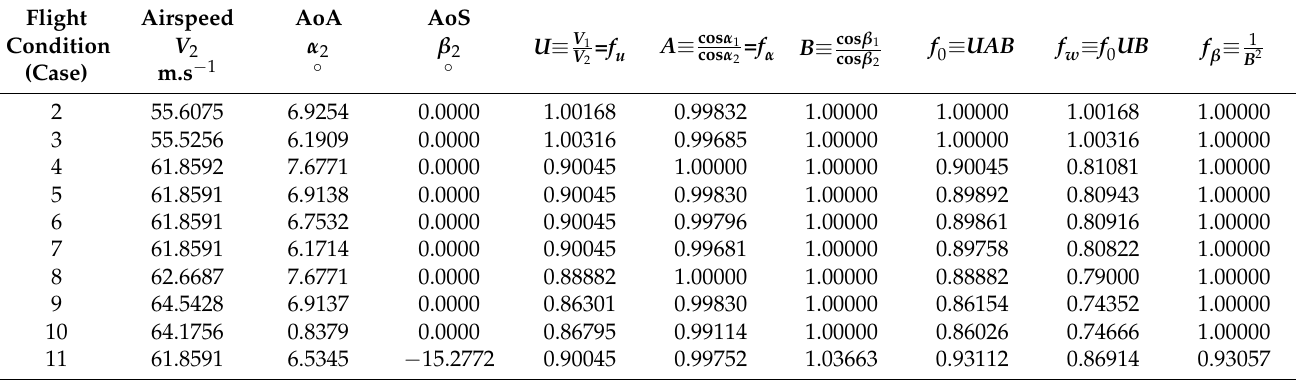
Table 5. Extrapolation from one to ten landing flight conditions.